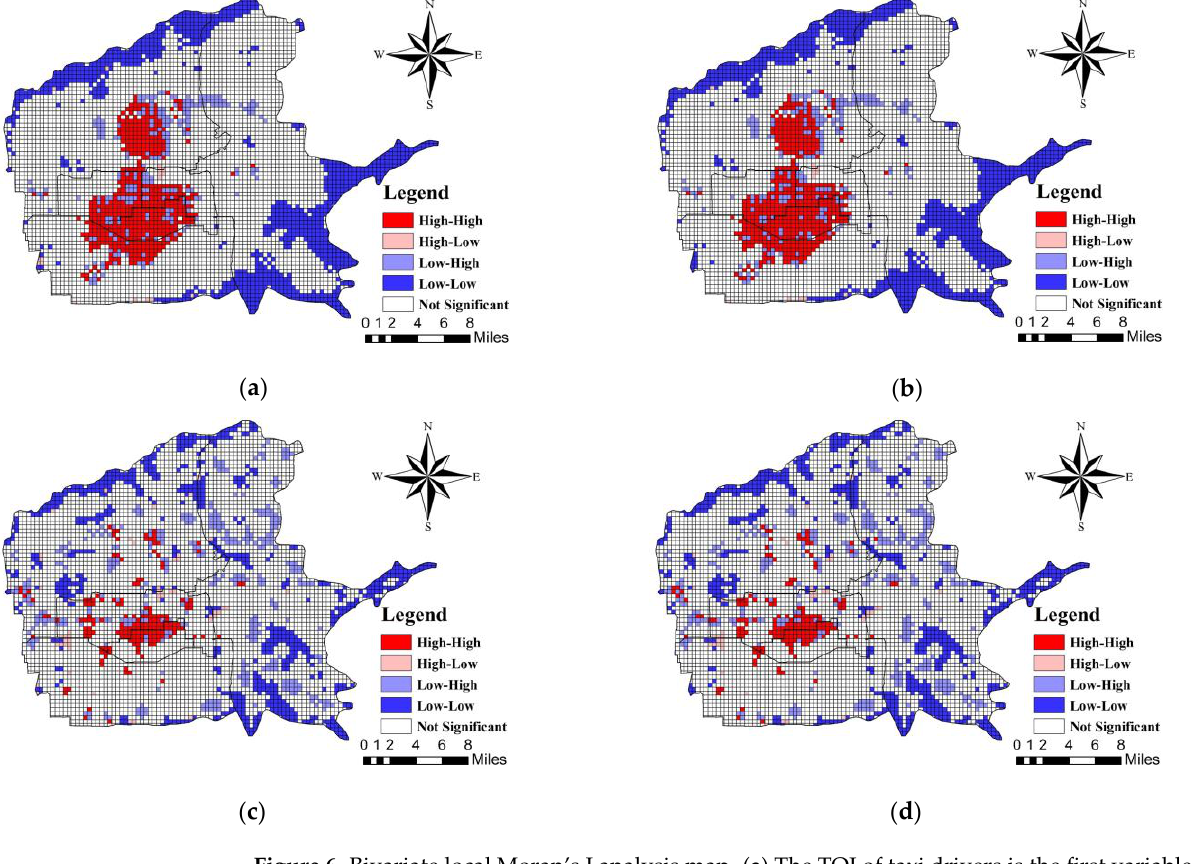
Figure 6. Bivariate local Moran’s I analysis map. ( a ) The TOI of taxi drivers is the first variable and NQPDA5000 is the second variable on working days. ( b ) The TOI of taxi drivers is the first variable and NQPDA5000 is the second variable on non-working days. ( c ) The TOI of taxi drivers is the first variable and TPBtA2000 is the second variable on working days. ( d ) The TOI of taxi drivers is the first variable and TPBtA2000 is the second variable on non-working days.